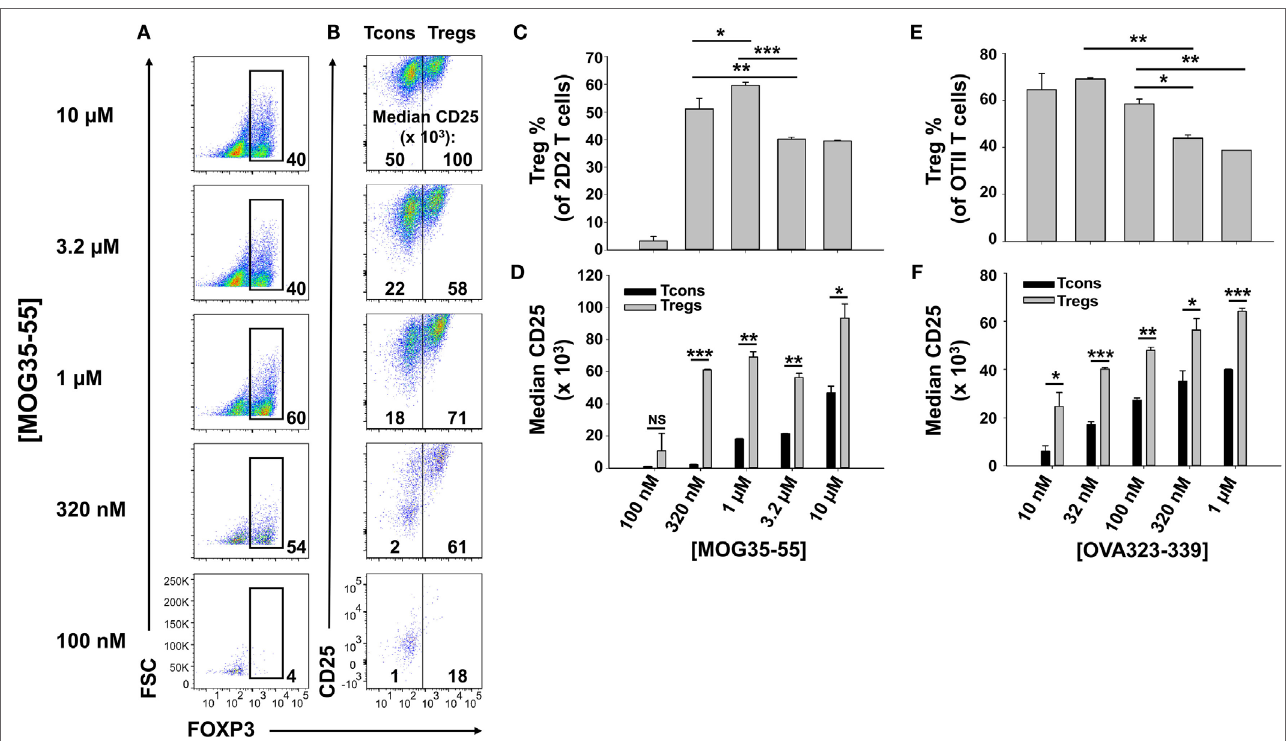
FigUre 1 | Intermediate concentrations of antigen induced higher percentages of FOXP3 + regulatory T cells (Tregs). 2D2-FIG (a–D) or OTII-FIG (e,F) splenocytes were activated at a density of 2 × 10 6 cells/ml cRPMI in the presence of 10 nM TGF- β with the indicated concentration of MOG35-55 or OVA323-339. After 3 days, V β 11 + (2D2) or V β 5.1 + (OT-II) T cells were analyzed for expression of FOXP3 (a,c,e) and CD25 (B,D,F) . Numbers at the bottom of each dotplot in panel (a) represent the percentages of FOXP3 + T cells, and the numbers in panel (B) represent the median fluorescence intensity of CD25 expression within the FOXP3 − [conventional T cell (Tcon)] and FOXP3 + (Treg) populations. * p < 0.05, ** p < 0.01, *** p < 0.001. These data are representative of three independent